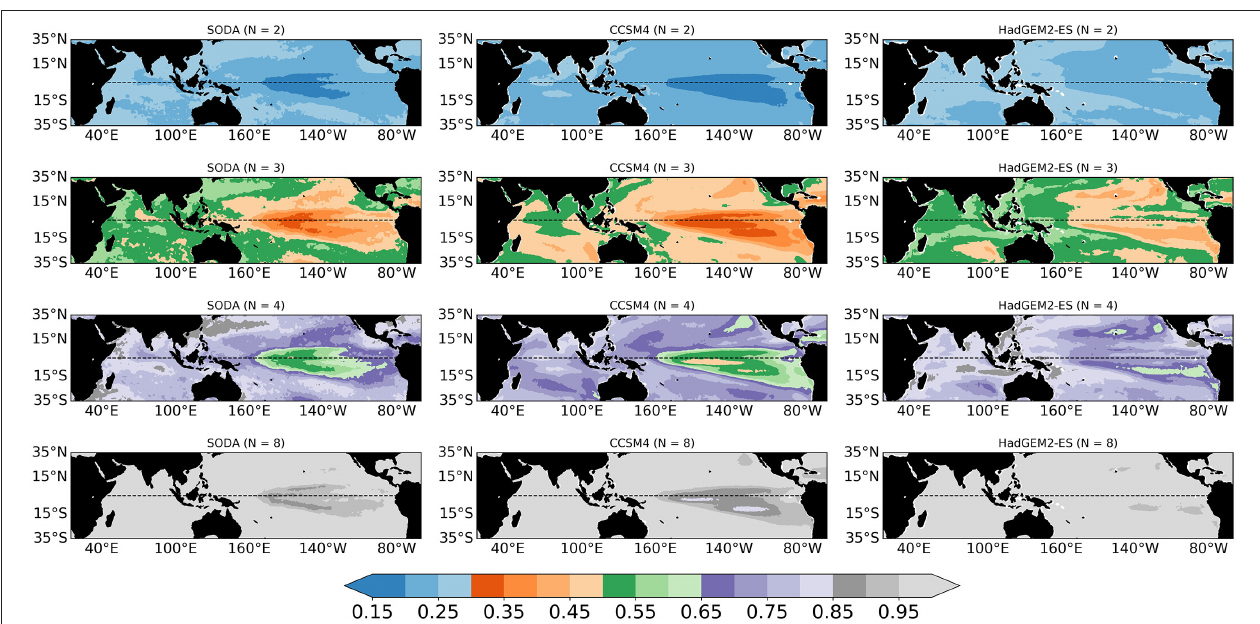
FIGURE 2 | SST entropy fields with microstates, M = 2, 3, 4, and 8 for SODA reanalysis (left column), CCSM4 (middle column) and HadGEM2-ES (right column) CMIP5 historical runs. The data span over the period 1967–2005 for models and 1980–2018 for SODA reanalysis. All months are